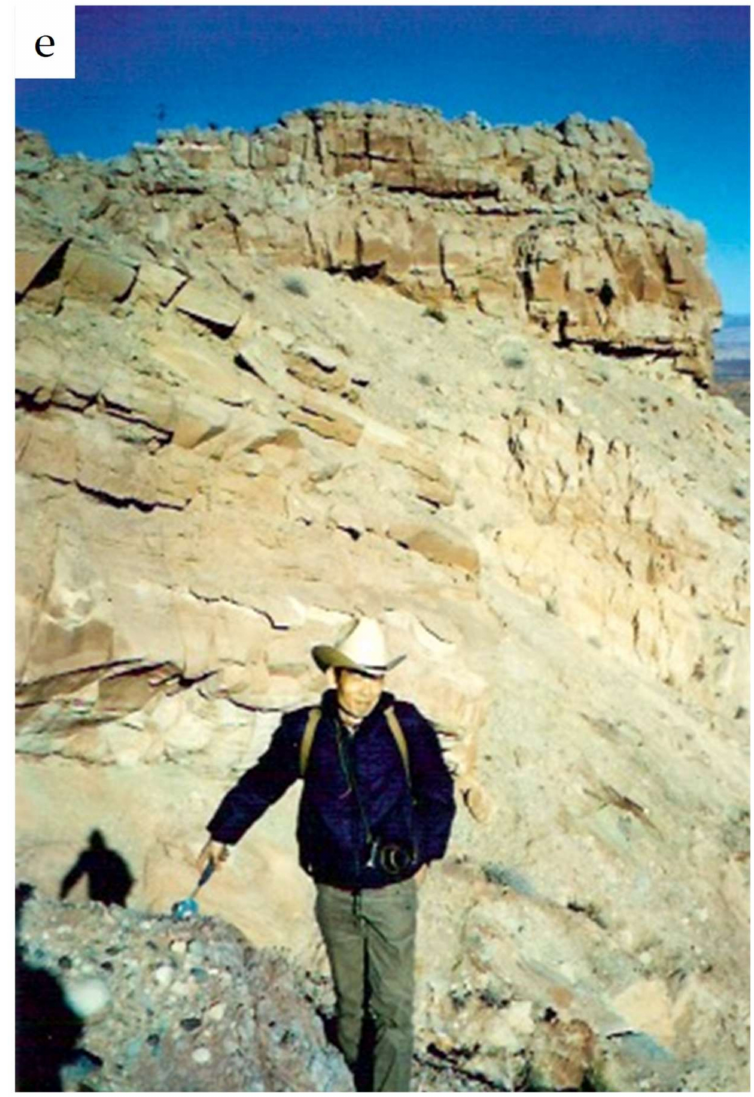
Figure 10. ( a ) Orson Anderson and Naohiro Soga being transported to the Mule Ear diatreme (in the background) via a rubber raft piloted by guide Kenny Ross; ( b ) field geologist Eugene Shoemaker showing outcrop from the Mule Ear diatreme to Edward Schreiber (ceramist), Orson Anderson (solid-state physicist with back turned), Naohiro Soga (industrial chemist), and Peter Molnar (seismologist); ( c ) Ed Schreiber viewing Alhambra Rock; ( d ) Orson Anderson on the Garnet Ridge diatreme; ( e ) Mineo Kumazawa at the Garnet Ridge